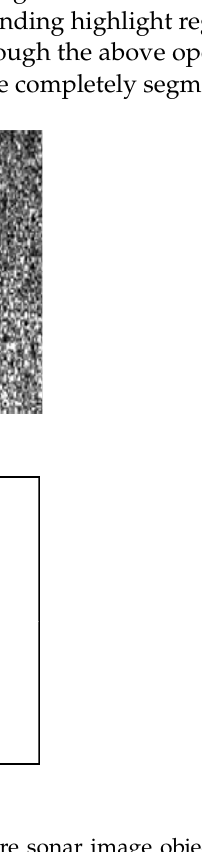
Figure 2. Synthetic aperture sonar image object segmentation results. ( a ) Original sonar image. ( b ) The highlight area of the object. ( c ) The shadow area of the object.